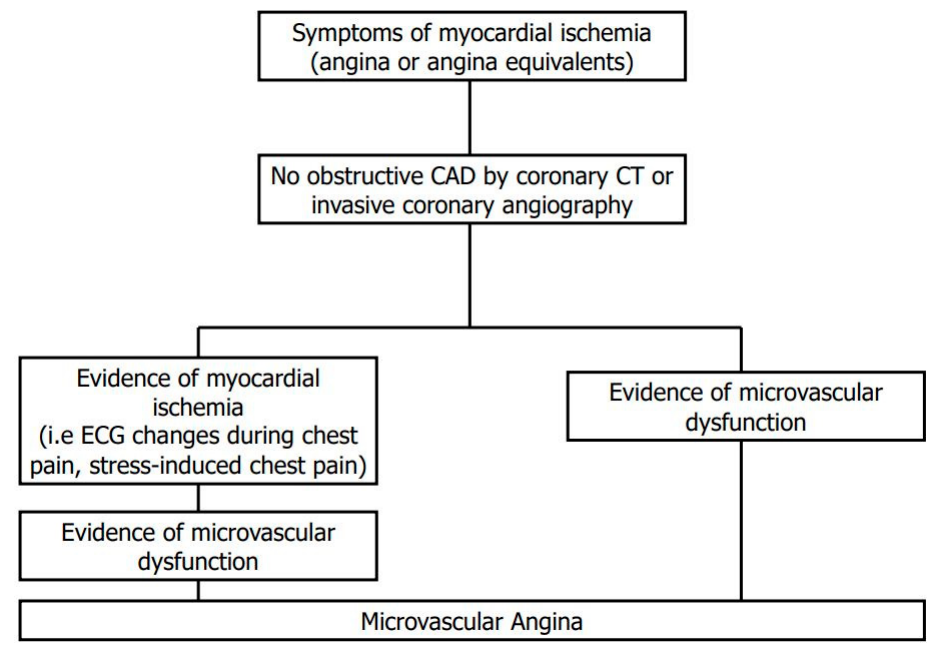
Figure 1. Flow chart for the diagnosis of microvascular angina according to current criteria. CAD = coronary artery disease; CT = computed tomography.